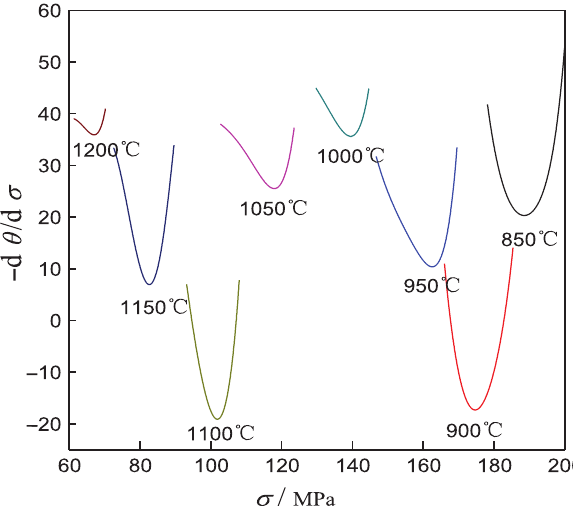
Figure 4: ( – d θ /d σ )- σ curves of samples deformed under tempera- tures from 850°C to